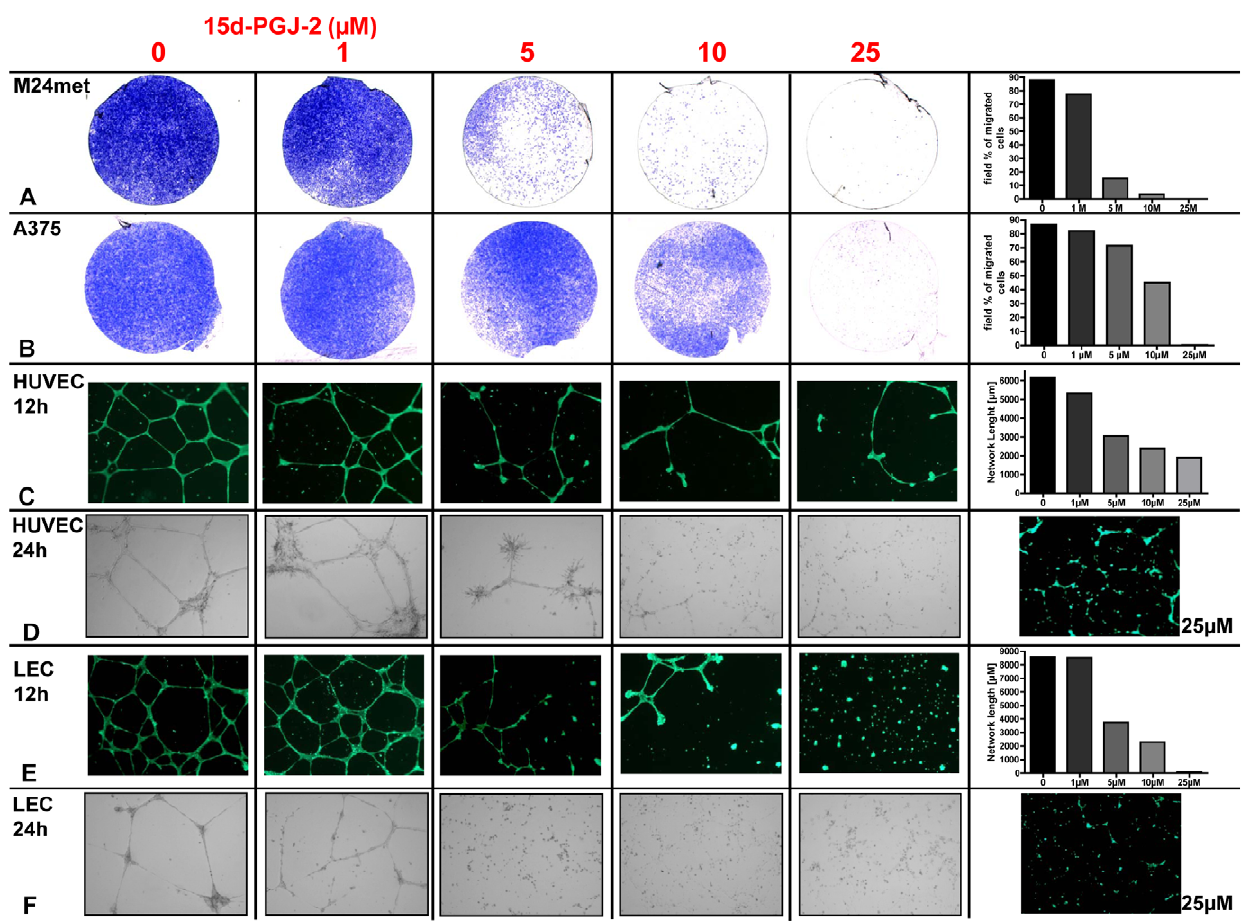
Figure 3. 15d-PGJ2 inhibits tumor cell migration and tube formation of HUVECs and LECs. A, B, Tumor cell migration assay after 48 hours of M24met melanoma cells and A375 melanoma cell line treated with 15d-PGJ2 with indicated concentrations. Representative pictures of three independent experiments. Quantification of the depicted experiment is performed using Axiovision Software. C–F, tube formation assay of HUVECs and LECs with indicated concentrations after 24 and 48 hours. Calcein staining was performed to monitor the vitality of the cells. Tube formation was quantified using Cell Profiler Software Package. Representative pictures of three independent experiments.